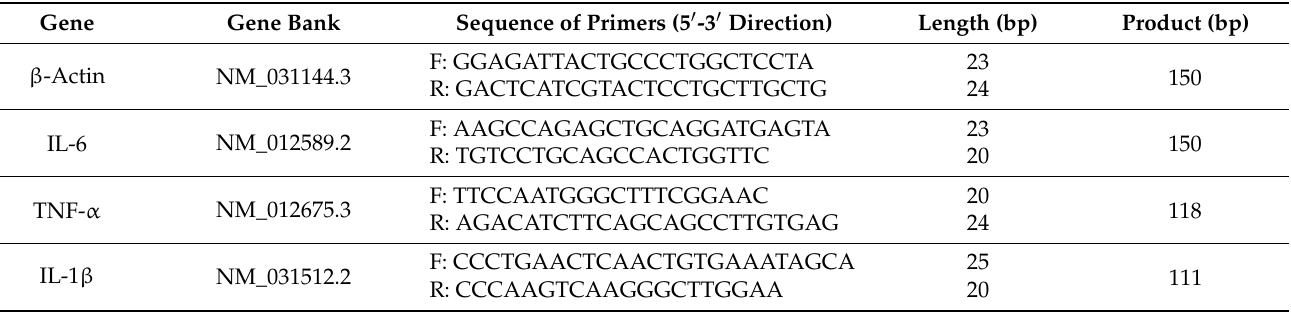
Table 3. Primer sequences used for